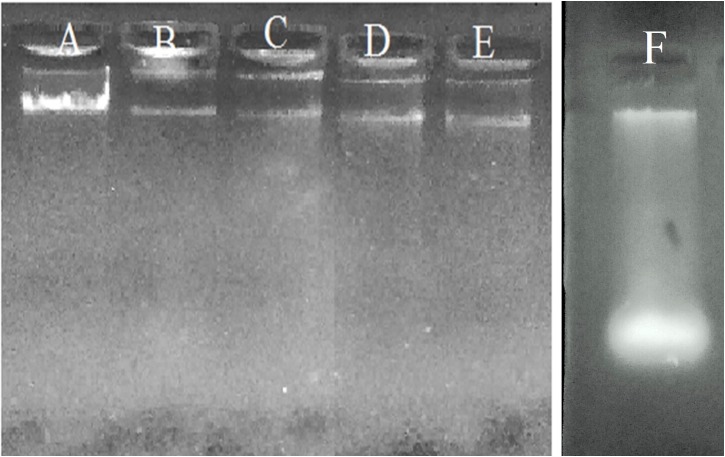
DNA extraction from the DPI-treated M. tuberculosis.DNA was extracted from actively growing and DPI-treated (4 μg/mL) Mtb samples and run on 1% agarose gel. A) Actively growing culture; B-E: 1st, 5th, 9th and 15th day DPI-treated cultures, respectively; F: UV-treated Mtb culture).